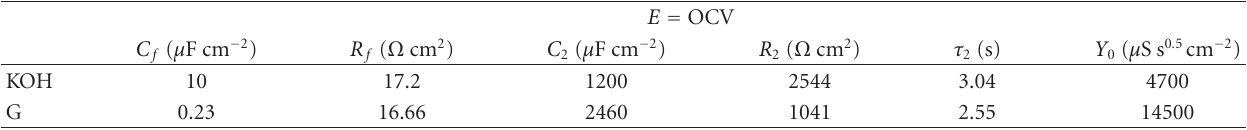
Table 2: Circuit parameters obtained by fitting the experimental impedance results with the selected equivalent circuit. Data obtained under irradiation ( λ = 365nm) in the presence and in absence of glycerol, E = OCV.